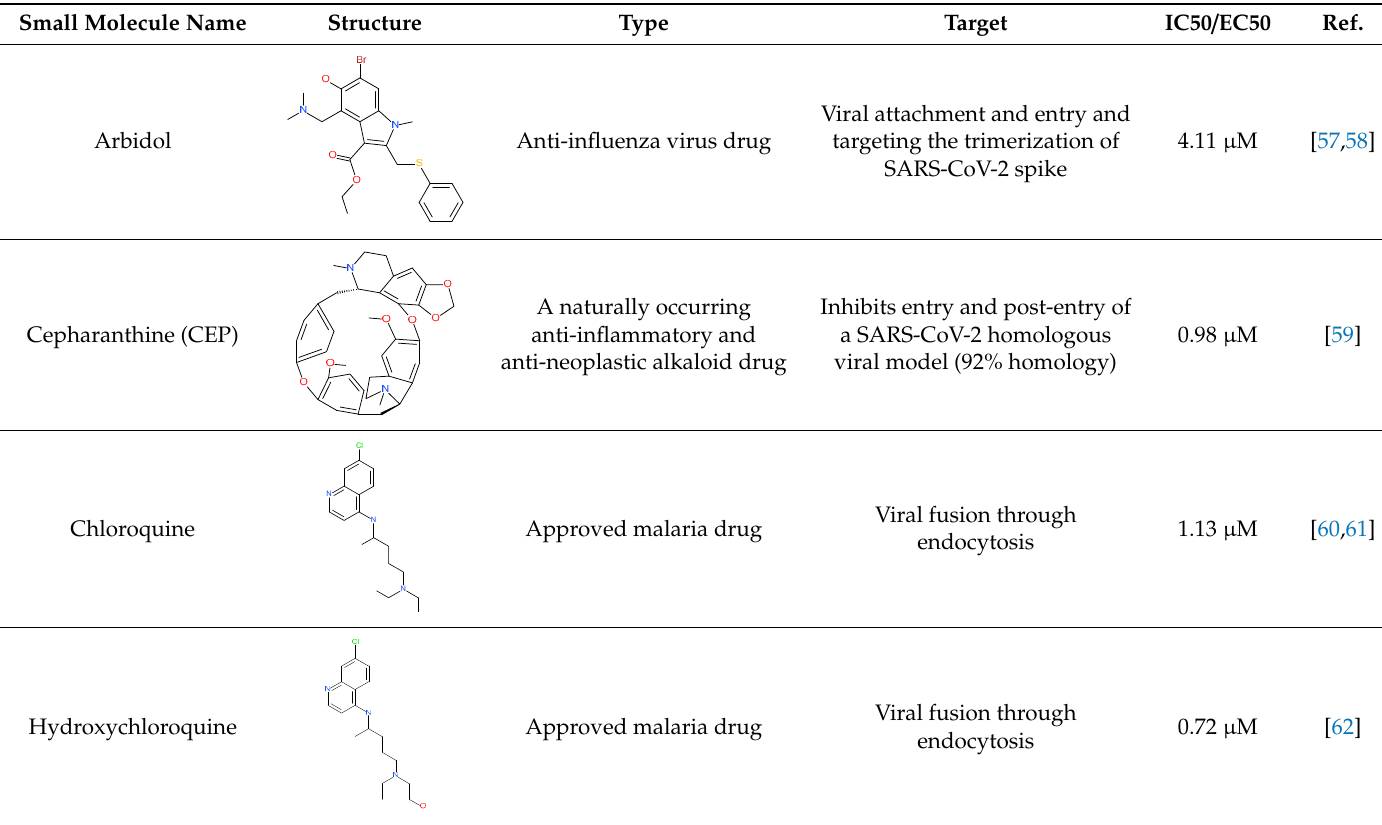
Table 2. Small molecules identified through experimental approaches for targeting the SARS ‐ CoV ‐ 2 spike protein.